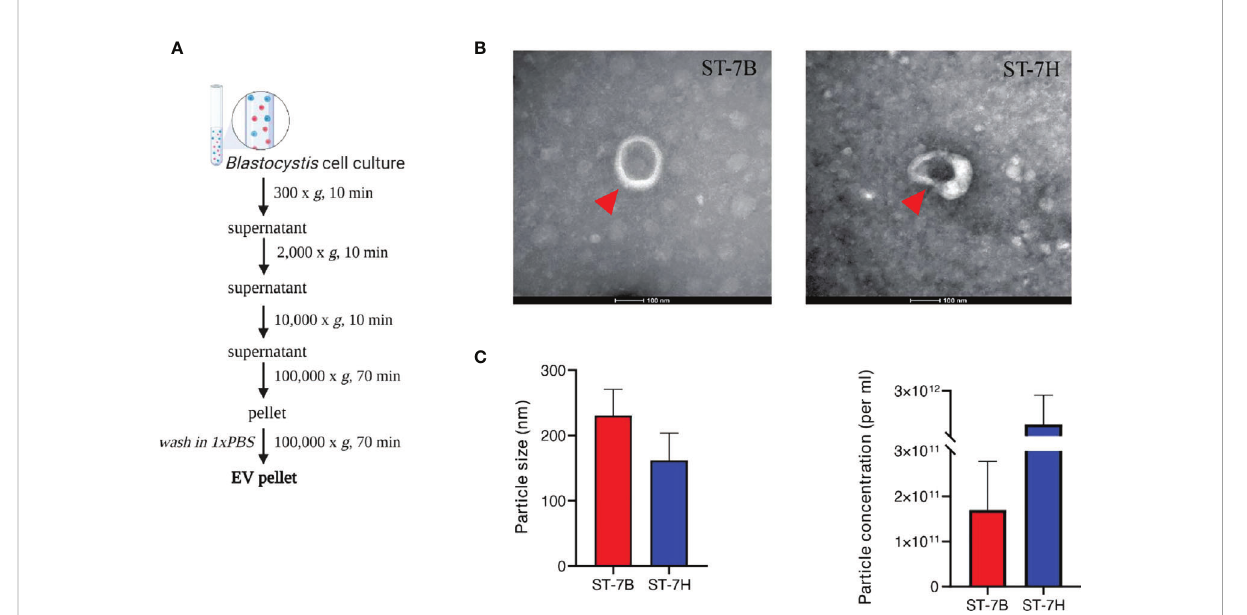
FIGURE 1 Characterization of extracellular vesicles from Blastocystis ST7 cultured in growth medium. (A) EV isolation protocol, adapted from The ́ ry et al. (The ́ ry et al., 2006). (B) Transmission electron microscopy of EVs from ST7B and ST7H. One EV is depicted in each image, indicated by the red arrow. Scale bar = 100nm. (C) Mean EV size and concentration produced by ST7B and ST7H under identical culture